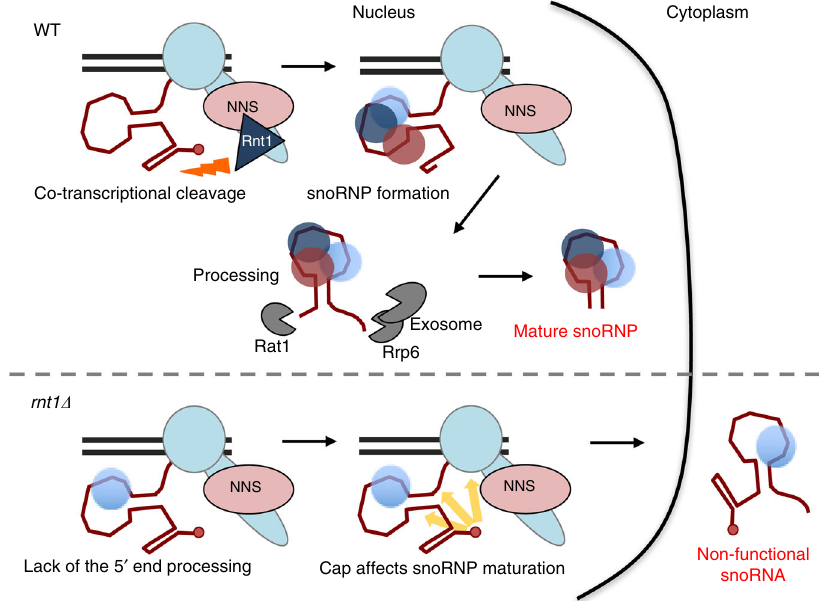
Fig. 7 Model for box C/D snoRNA maturation in yeast. Co-transcriptional cleavage mediated by Rnt1 removes the cap structure from box C/D pre-snoRNA and so directs the precursor to the snoRNP synthesis pathway in WT cells. In the rnt1 Δ strain, retained m 7 G cap marks the RD box C/D pre-snoRNA as mRNA resulting in cytoplasmic localization of 5 ʹ and 3 ʹ unprocessed